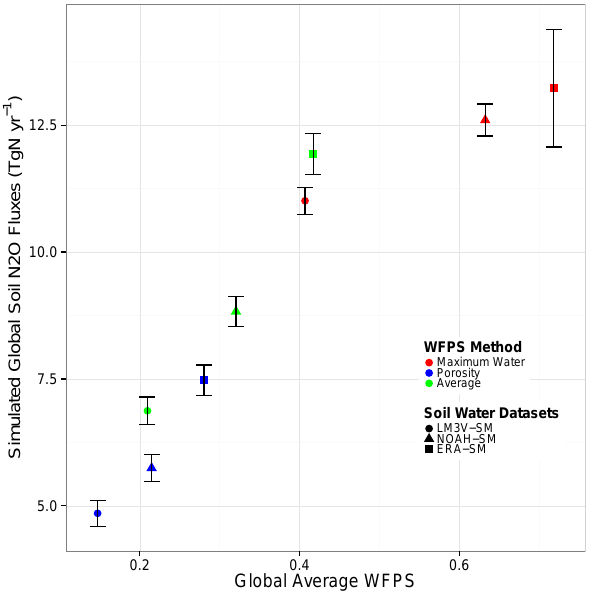
Figure 3. Sensitivity of simulated global soil N 2 O emissions (with potential vegetation) to water-filled pore space (WFPS). The x axis is the WFPS averaged globally over 1982–2005; the y axis repre- sents the corresponding global total N 2 O fluxes. A total of nine sets of WFPS are obtained through either different soil water data sets (symbols) or varied calculation methods (colours). Maximum water, porosity and average correspond to method 1, method 2 and method 3 in the main text, respectively. Coloured symbols represent means and error bars indicate interannual standard deviations.